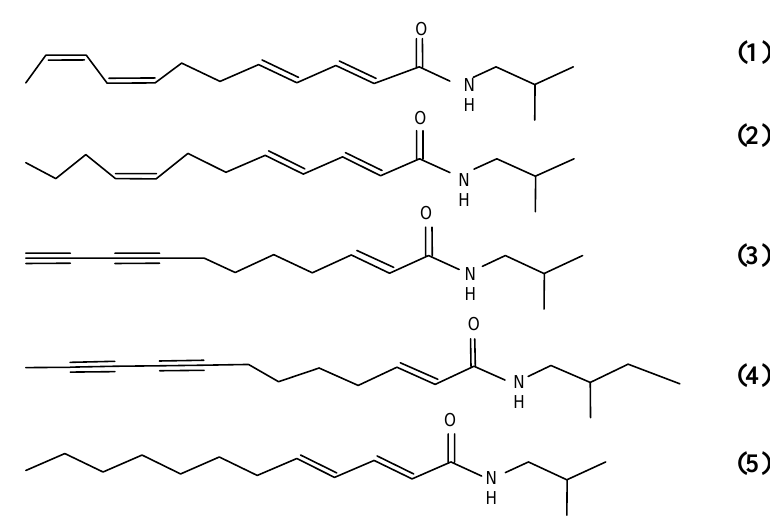
Figure 3: Echinacea alkylamide structures.